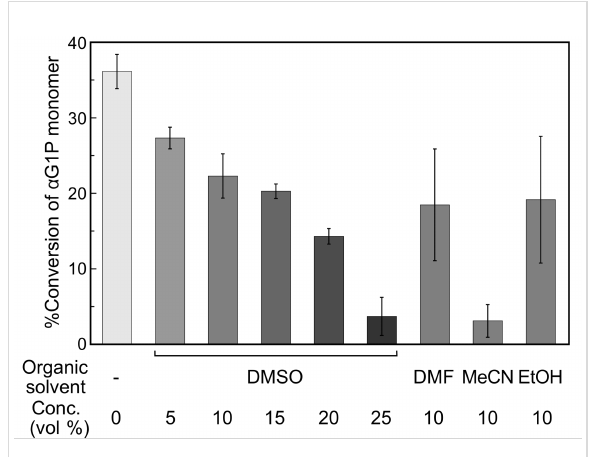
Figure 3: The α G1P monomer conversion into insoluble products with organic solvents.